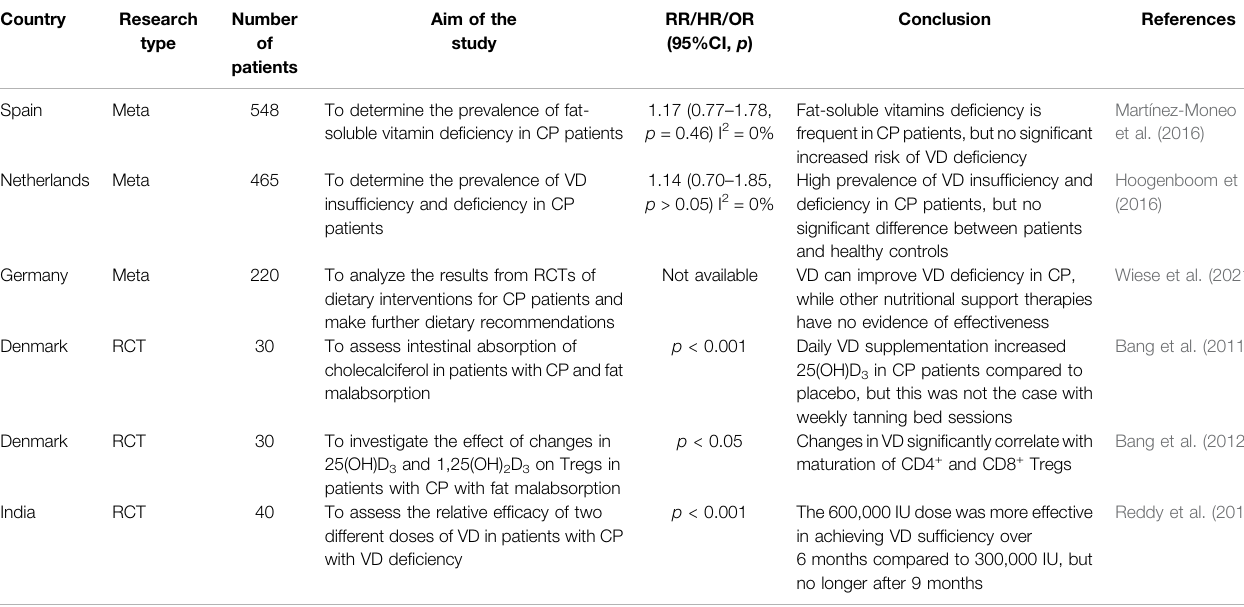
TABLE 3 | Summary on the roles of vitamin D (VD) in CP from clinical studies.